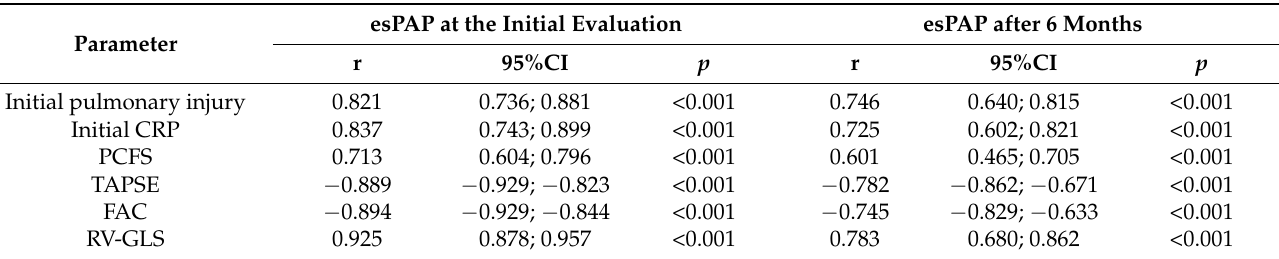
Table 2. Correlations between the initial and 6 months’ values of esPAP and other parameters.